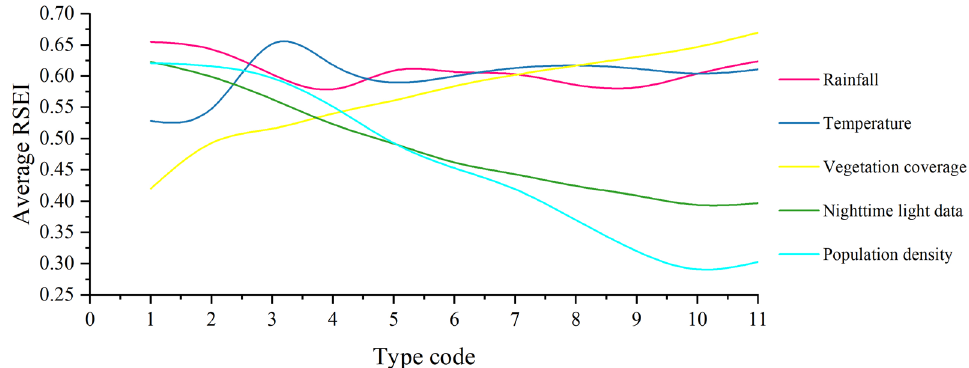
Figure 7. Change trend between average RSEI and influencing